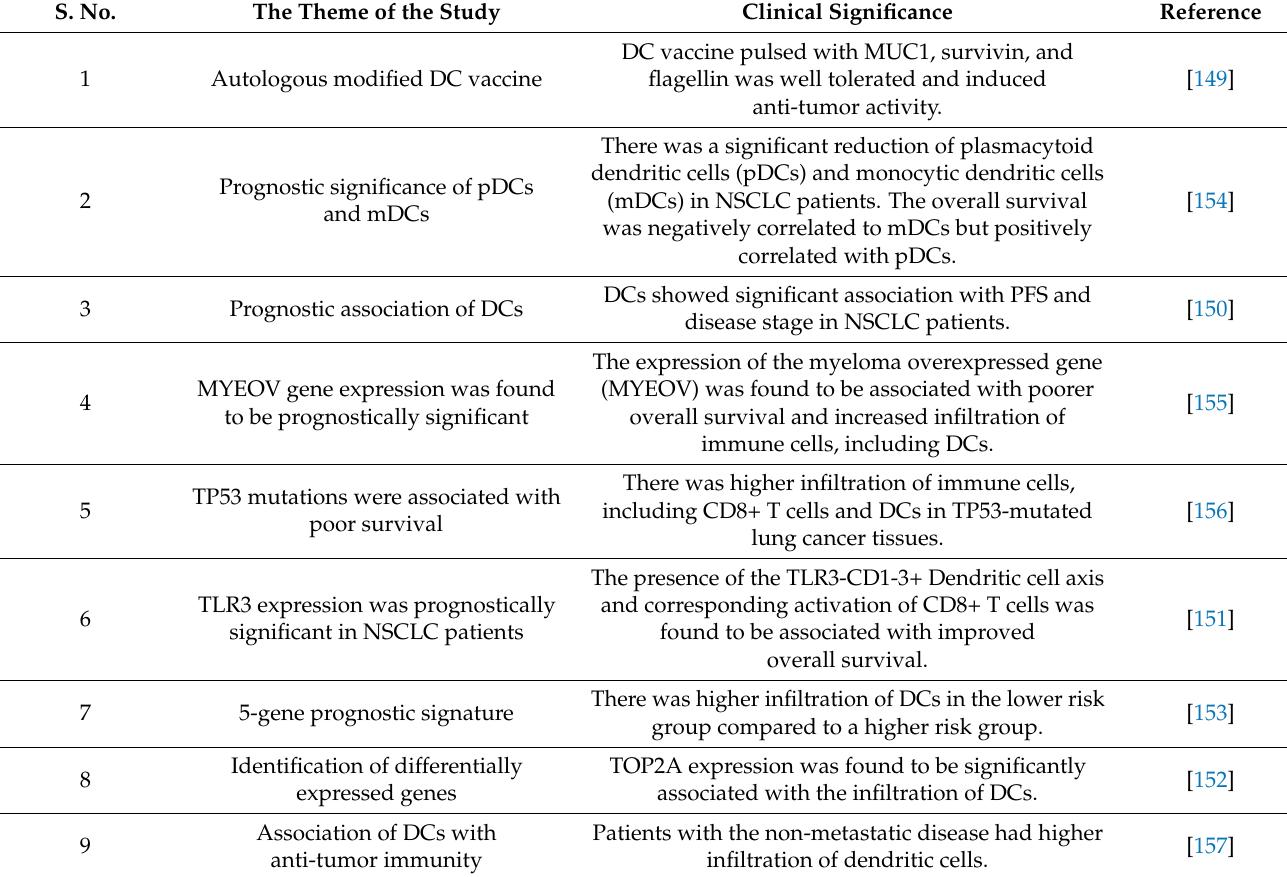
Figure 3. Types of DCs, their function, and their clinical approaches to tap into their potential for the therapeutic benefit of cancer patients. Table 2. Recent advances in identifying prognostic roles of DCs cells in NSCLC.